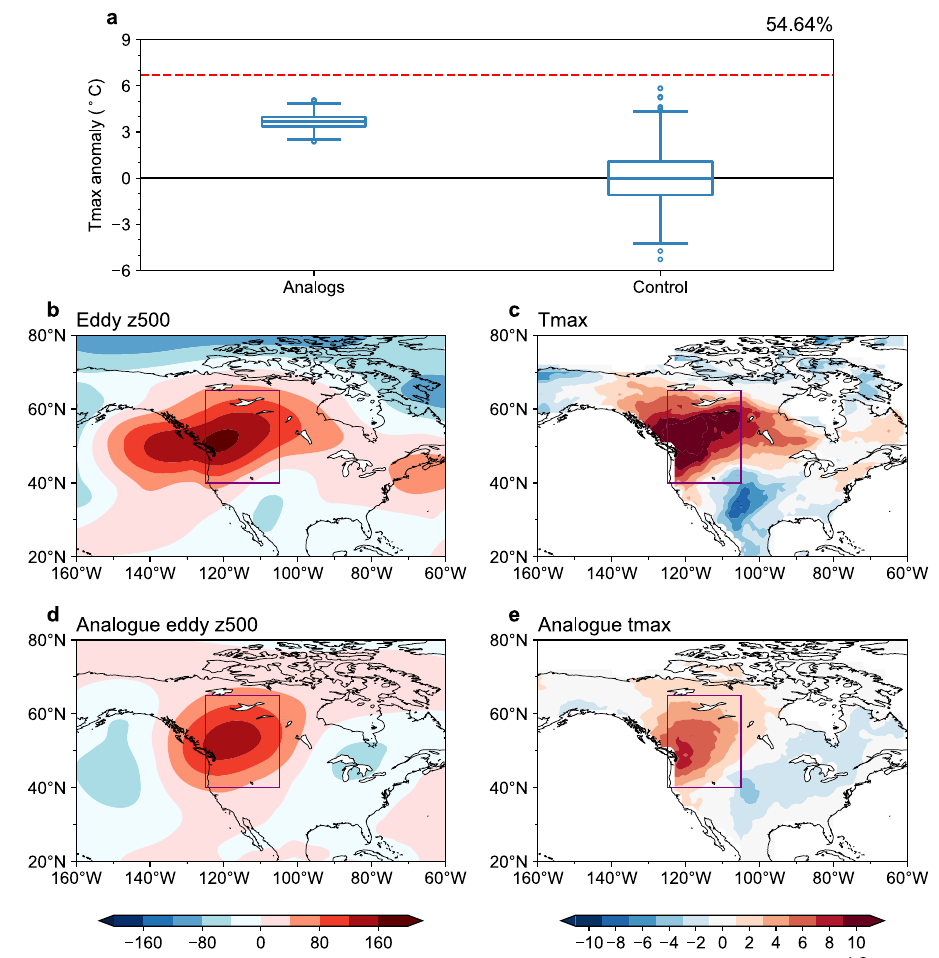
Fig. 2 | The contribution of the heat dome to 2021 heatwave over the Western North America. a The distribution of the maximum temperature anomalies (detrend, unit: °C) for fl ow analog days generated using eddy geopotential height anomalies at 500 hPa from 27 June – 3 July and randomly picked days (control) during1959 – 2020.Thethreelinesofboxesdenotethe25thpercentile,medianand 75th percentile from bottom to top, respectively. The red line indicates the